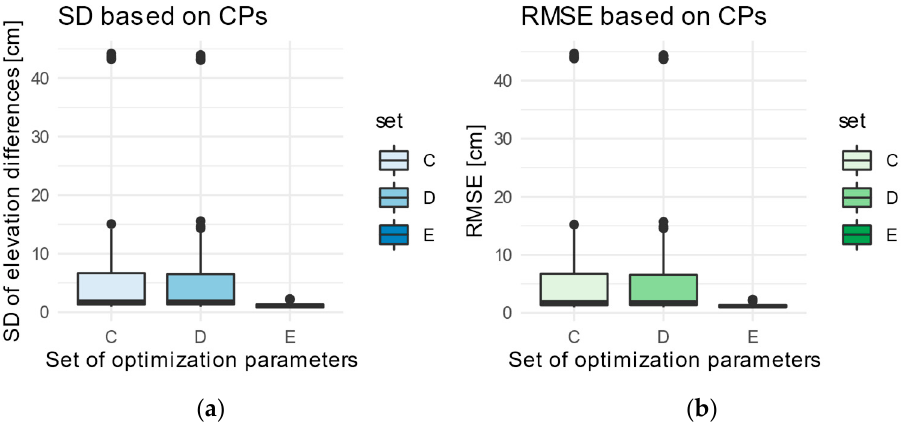
Figure 6. Distribution of standard deviation ( a ) and RMSE ( b ) values based on CPs. The figure suggests that use of the “E” set would result in lower error values. For the projects with the “E” set, no DEMs with very high errors of ~45 cm were found.